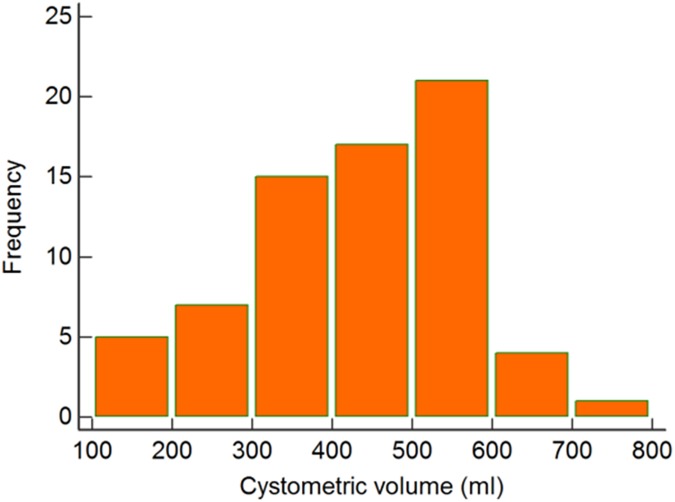
(a) Distribution of cystometric volume in 70 patients.